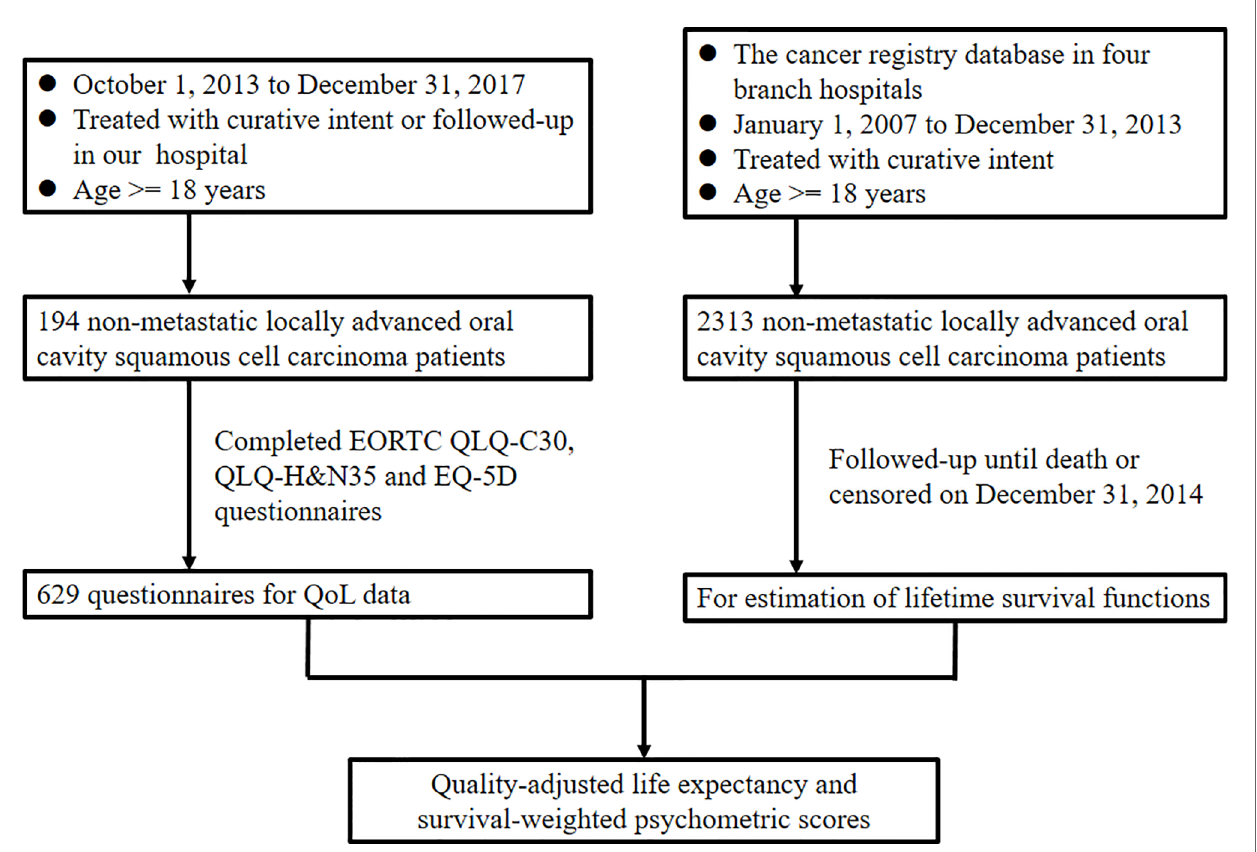
FIGURE 1 | Study design fl owchart. EORTC, European Organisation for Research and Treatment of Cancer; H&N, head and neck; QLQ, quality of life questionnaire; QoL, quality of